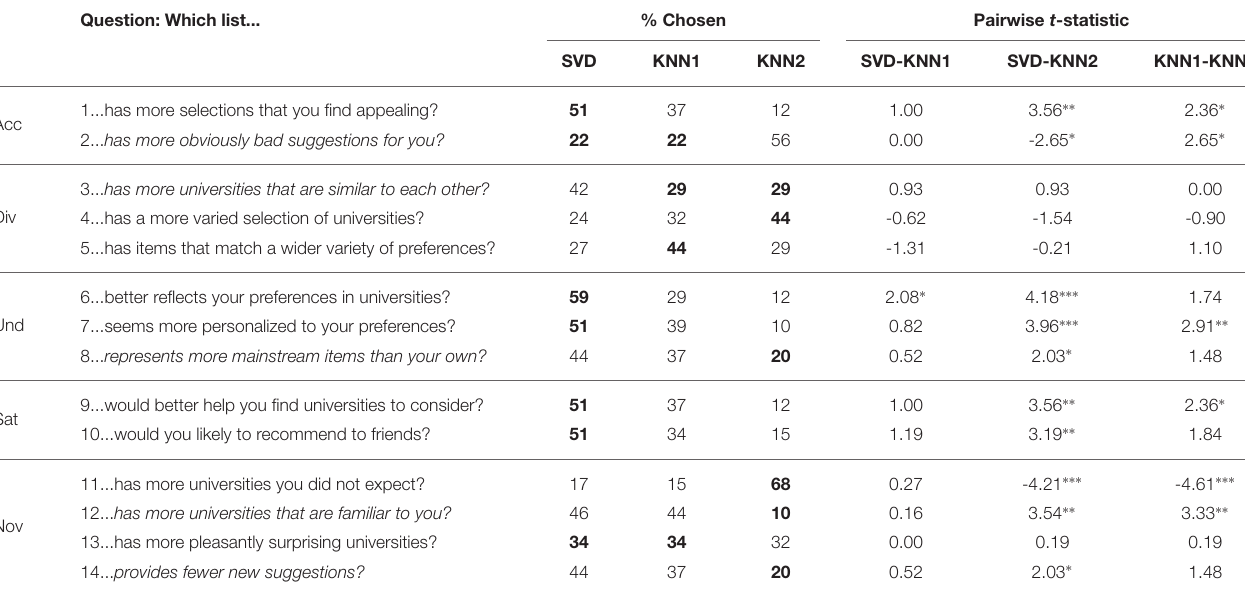
TABLE 2 | Results of paired t -tests on different evaluation metrics (based on Ekstrand et al., 2014), in which users were asked to choose a recommendation list in relation to specific metrics. Question: Which